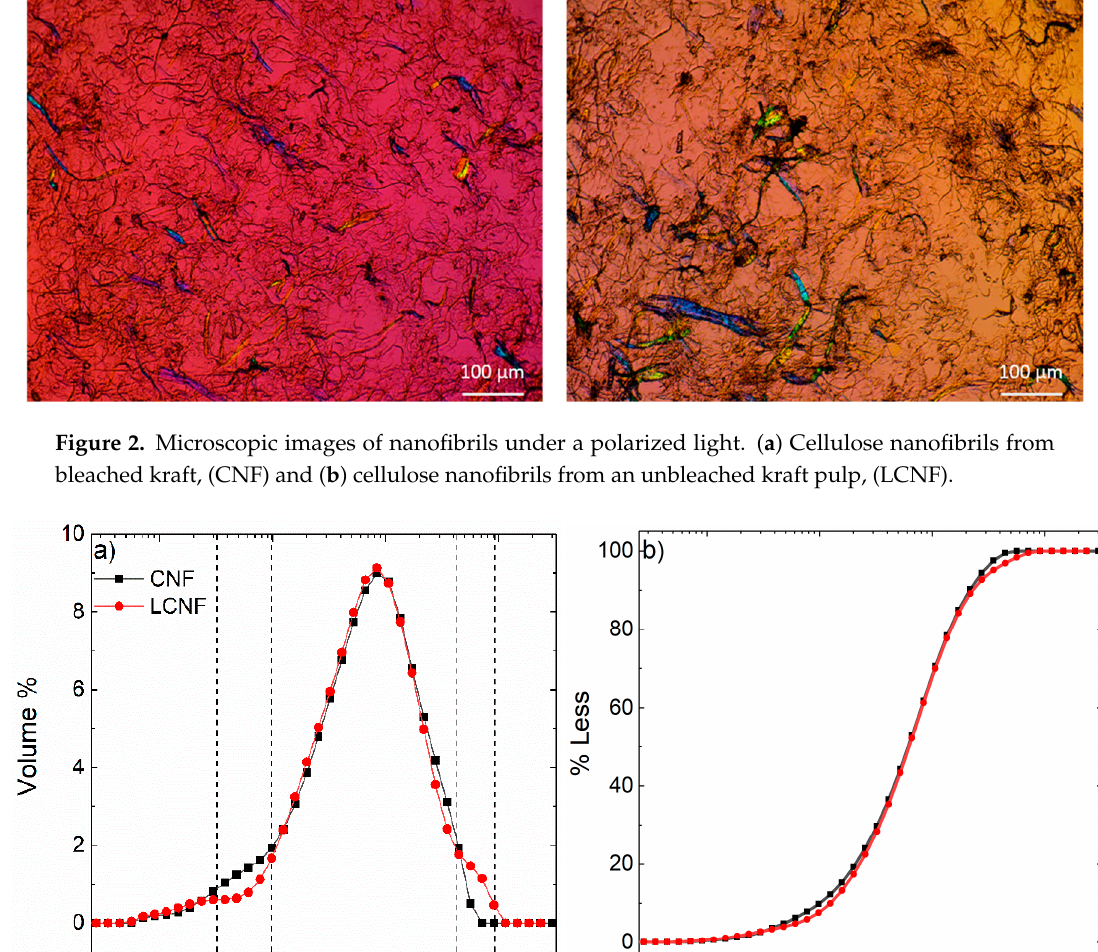
Figure 2. Microscopic images of nanofibrils under a polarized light. ( a ) Cellulose nanofibrils from bleached kraft, (CNF) and ( b ) cellulose nanofibrils from an unbleached kraft pulp, (LCNF).